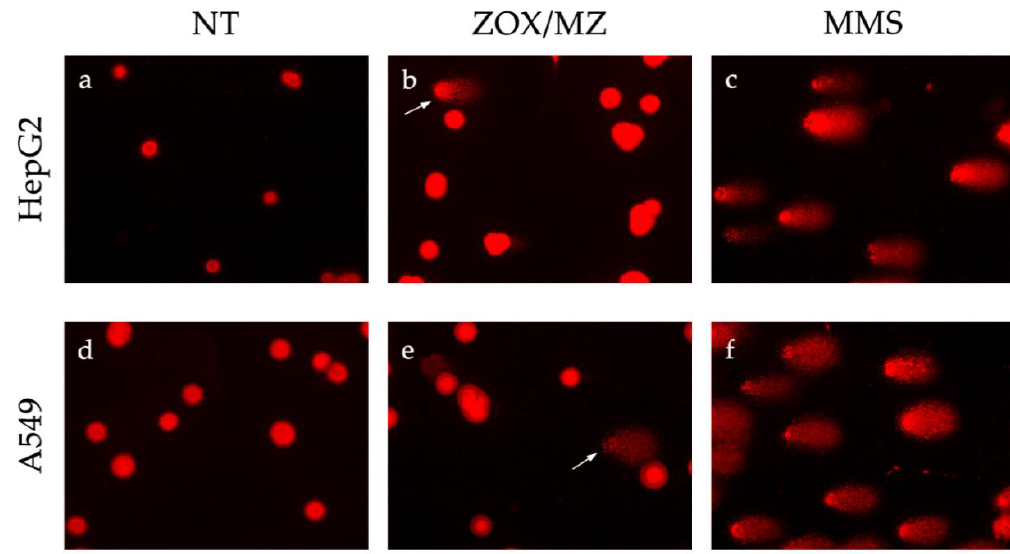
Figure 6. Fluorescence microscope images of HepG2 ( a – c ) and A549 ( d – f ) nucleoids. Control cells ( a , d ); HepG2 treated with ZM 46.34 μM for 5 h ( b ); A549 treated with MZ 29.6 μM for 24 h ( e ); cells treated for 30 min with MMS 1 mM as positive controls ( c , f ). White arrows show the n ucleoids with damaged DNA or “comets” .